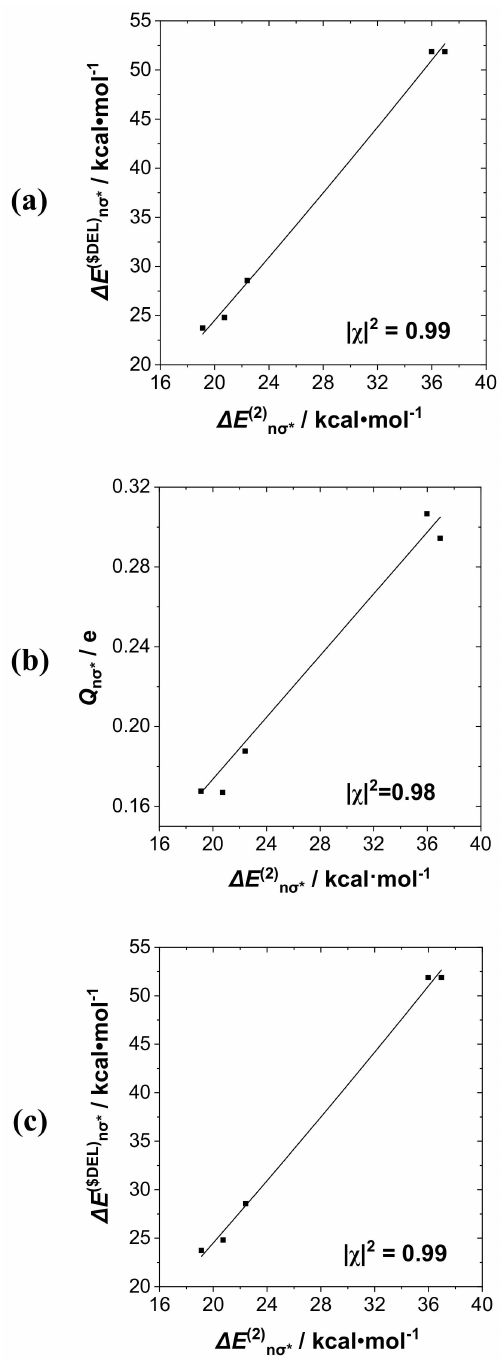
Figure 6. Correlation diagrams for ( a ) ∆ E (2) n σ * - ∆ E ($DEL) n σ * , ( b ) ∆ E (2) n σ * - Q n σ * , and ( c ) ∆ E (2) n σ * - b P ··· I descriptorsofRPH 2 ··· IFspecies, showingleast-squaresregressionlineandPearsoncorrelationcoe ffi cient | χ | 2 for each